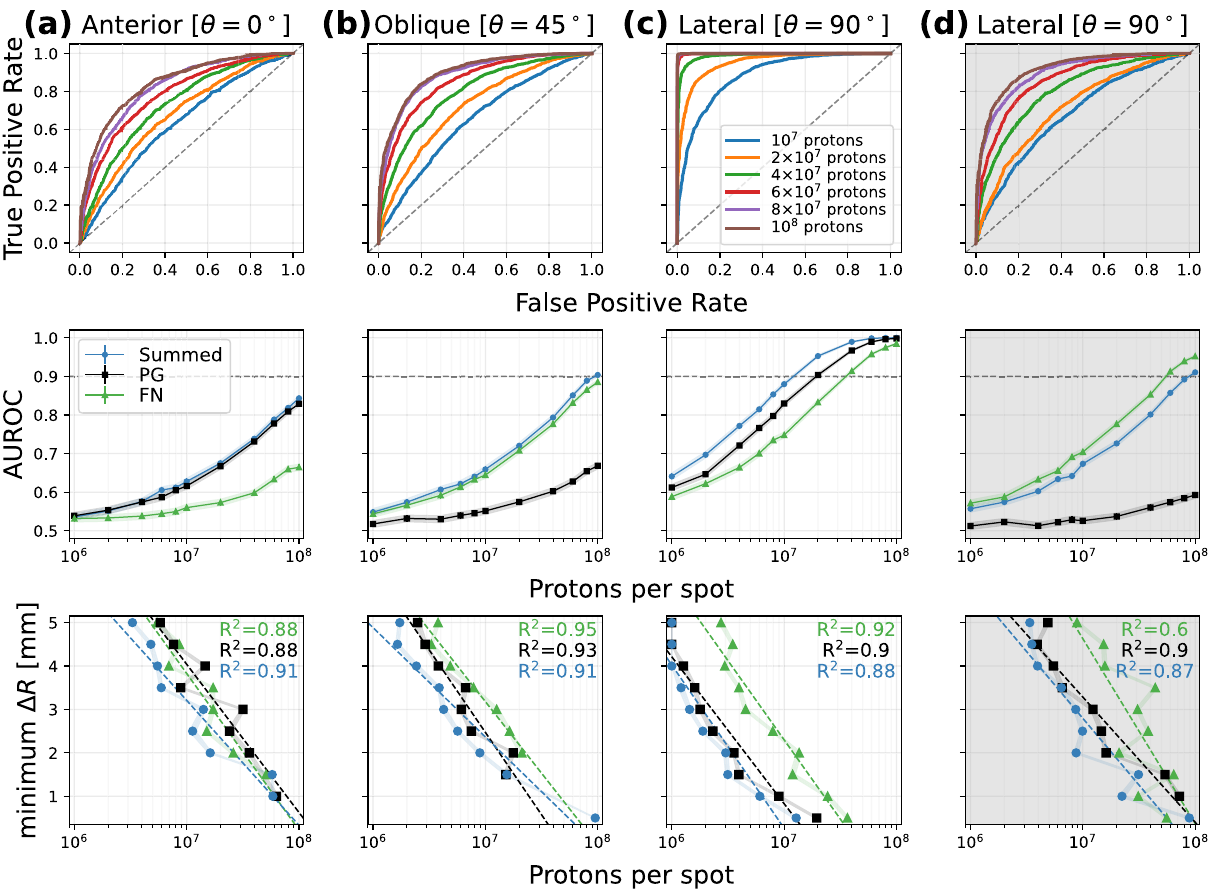
Figure 5. Receiver Operating Characteristic (ROC) curves, and average Area Under ROC ( AUROC ) curves for a range shift of 0.5mm and minimum detectable range shifts. The upper panel shows the ROC curves evaluated at a range shift magnitude of 0.5mm for the reconstructed FN and PG combined data-set. The middle panel shows the calculated AUROC for the same data-set at the same range shift magnitude. The lower panel shows the minimum detectable range shifts as a function of the number of protons per spot. Note that ROCs 7 8 are only plotted for proton intensities ranging from 10 protons/spot to 10 protons/spot whereas AUROC and 6 8 minimum (cid:31) R are plotted for proton intensities ranging from 10 protons/spot to 10 protons/spot. Each of these are shown for a NOVCoDA orientation of θ = 0 ◦ ( a ), θ = 45 ◦ ( b ) and θ = 90 ◦ ( c ), as well as the θ = 90 ◦ case with the estimated effects of time, energy, and position resolutions (and segmentation of a realistic detector) included in ( d ). The uncertainties in terms of one standard deviation are shown as bands around the AUROC